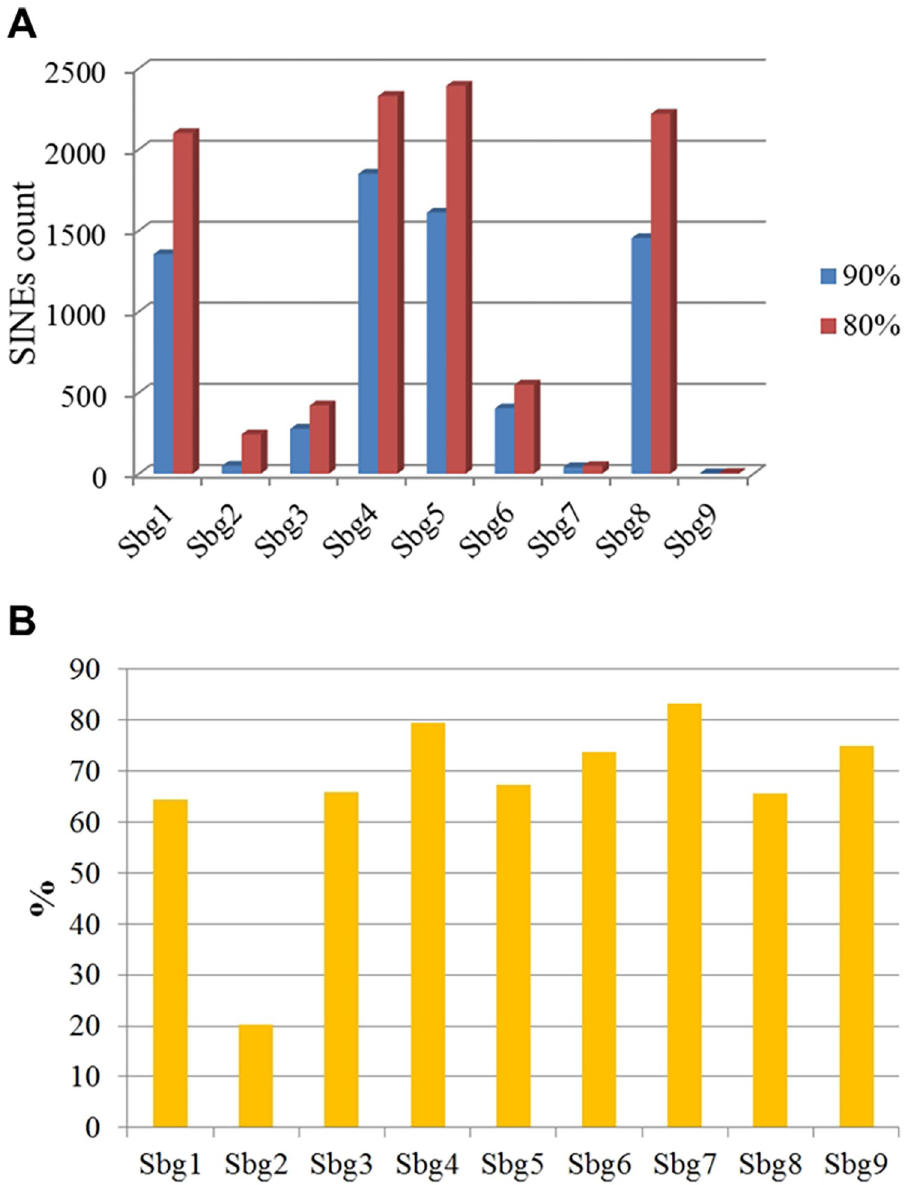
Fig 2. Analysis of the copy number of the described SINEs. ( A) The ratio of the copy numbers of SINEs of each type (Sbg1-Sbg9) having different degrees of similarity in relation to their consensus sequences: blue and red bars-90% or more and 80% or more similarity, respectively. The abscissa is the SINE type; the ordinate is the number of SINE copies; ( B) For each type of SINE, proportion of copies with the highest (90% or more) similarity to consensus sequences among copies with 80% or more similarity. The abscissa is the SINE type; the ordinate shows the percentage.